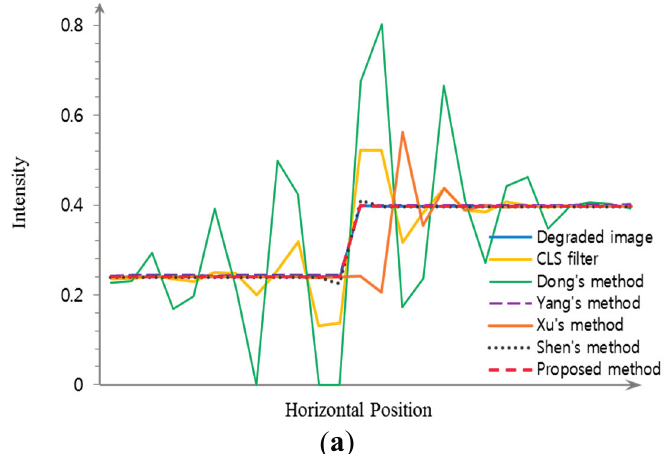
Figure 9. Comparison of different restoration algorithms using a synthetic image; ( a ) the input image; ( b ) the degraded image by spatially varying blur; ( c ) the restored image by the constrained least squares (CLS) filter (peak-to-peak signal-to-noise ratio (PSNR) = 33.13, mean structural similarity (MSSIM) = 0.94); ( d ) the restored image by the Dong’s method [24] (PSNR = 26.68, MSSIM = 0.84); ( e ) the restored image by the Yang’s method [25] (PSNR = 36.44, MSSIM = 0.97); ( f ) the restored image by the Xu’s method [12] (PSNR = 29.62, MSSIM = 0.93); ( g ) the restored image by the Shen’s method [14] (PSNR = 36.88, MSSIM = 0.98); and ( h ) the restored image by the proposed method (PSNR = 39.19, MSSIM =